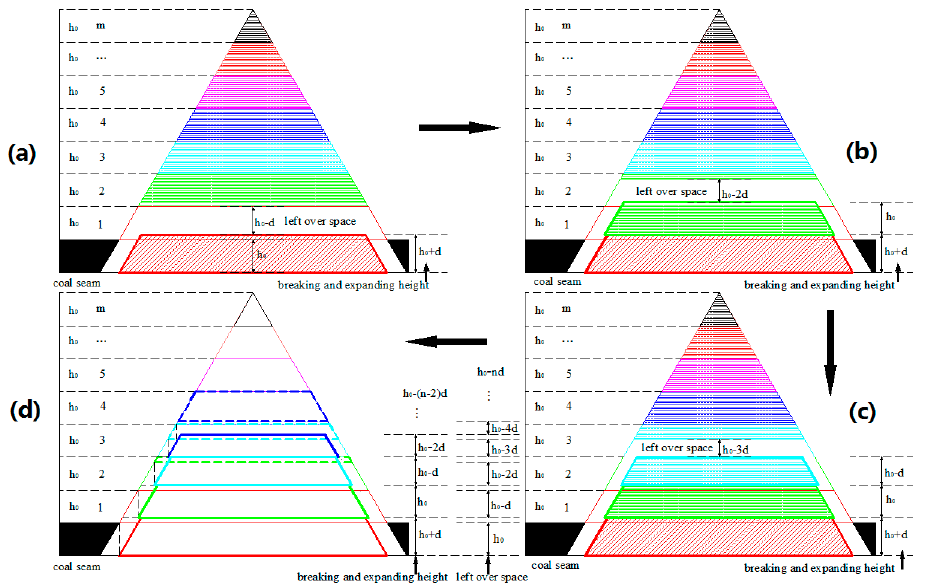
Figure 3. Schematic cross-sectional drawing of the trapezoidal broken model showing the sequential caving of Model I: ( a ) after the (0)th layer failure of the roof stratum due to coal extraction, ( b ) after (1)th layer failure of the roof stratum, ( c ) after (2)th layer failure of the roof stratum, ( d ) after the ( n − 1)th layer failure of the roof stratum.